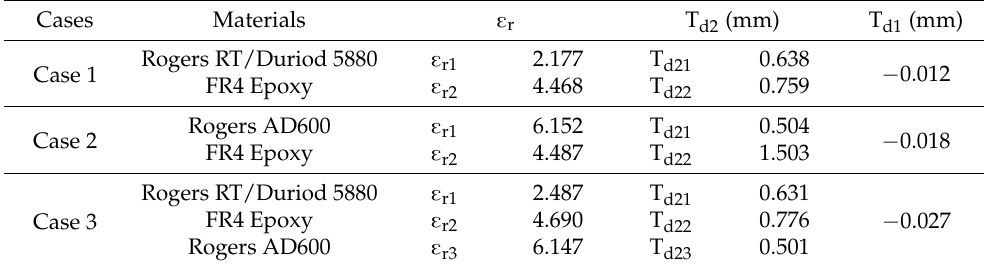
Figure 4. Confidence in the estimated model parameters. Table 2. Summary of Multi-layer Material Estimation.